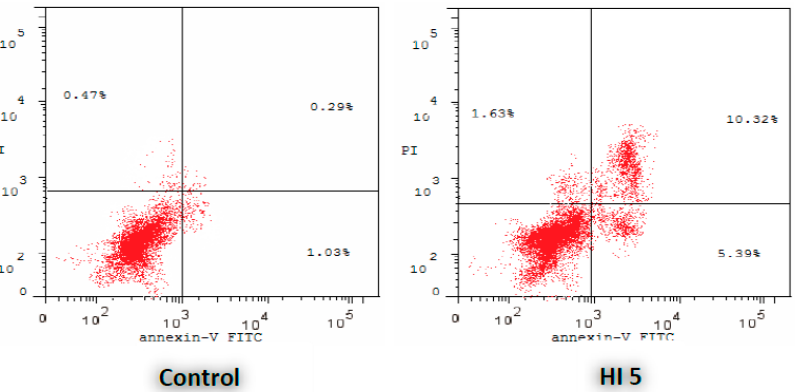
Figure 3. Effect of HI 5 on the percentage of annexin V-FITC-positive staining in MCF-7 cells. The four quadrants identified as: LL , viable; LR , early apoptotic; UR , late apoptotic; UL ,